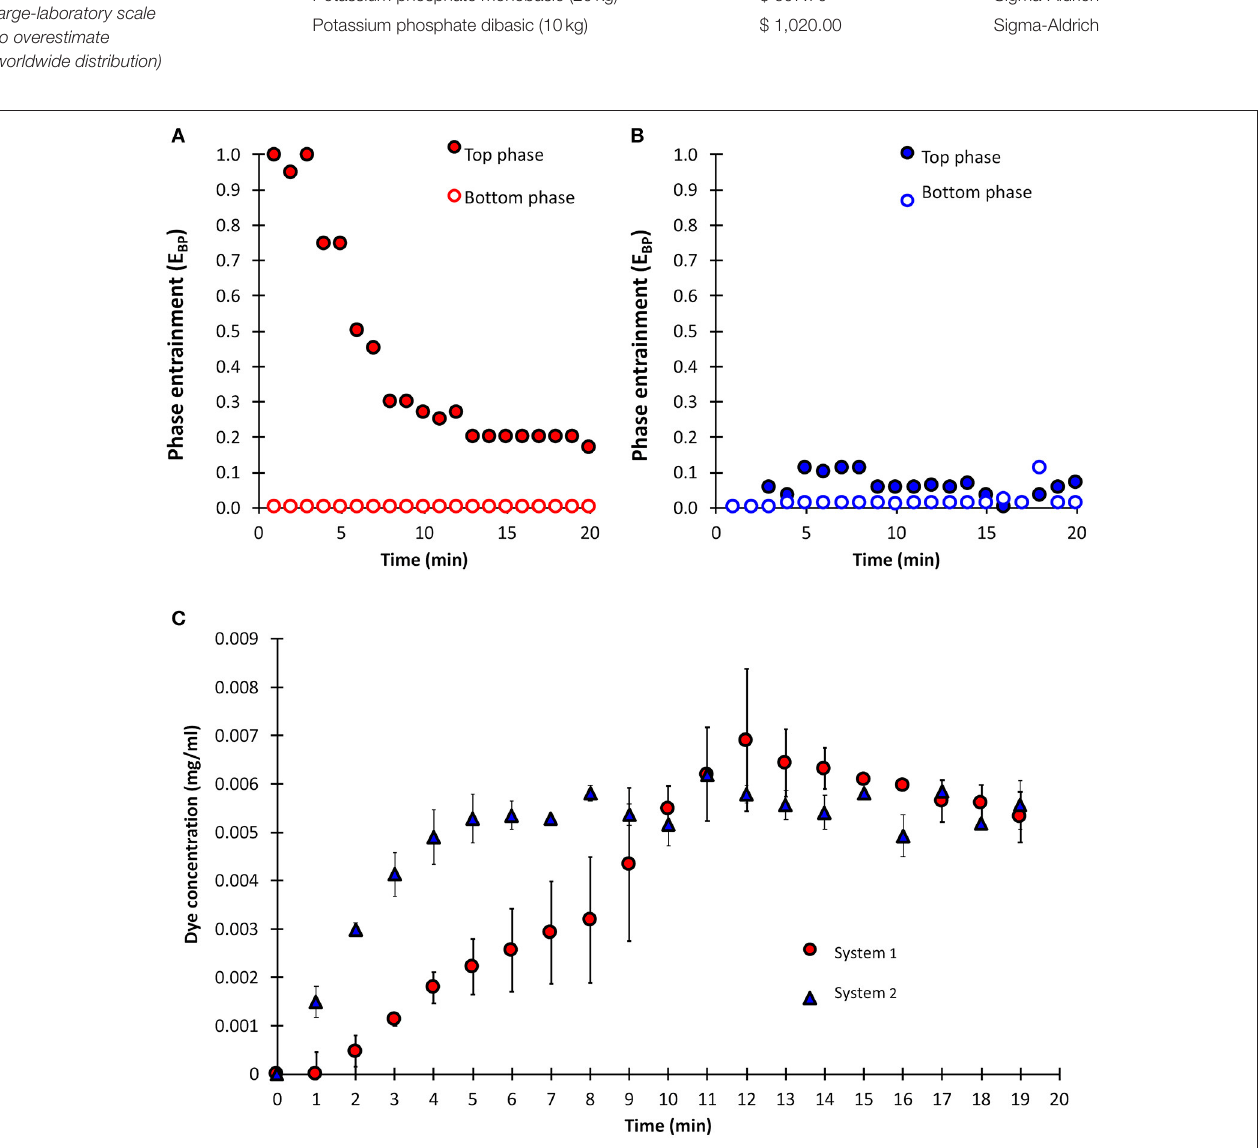
FIGURE 2 | Phase entrainment (E BP ) comparison between System 1 (A) and System 2 (B). Concentration of gentian violet used as tracer in top phase of Systems 1 and 2 (C) .